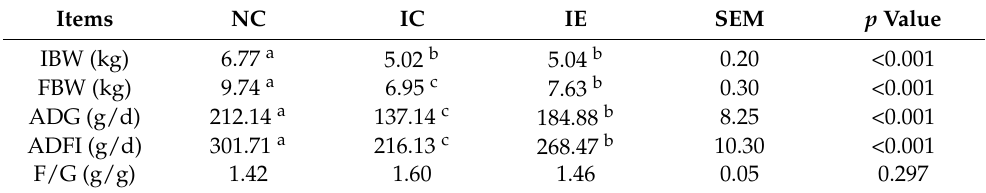
Table 3. Effects of dietary EGF supplementation on the growth performance of piglets with IUGR.